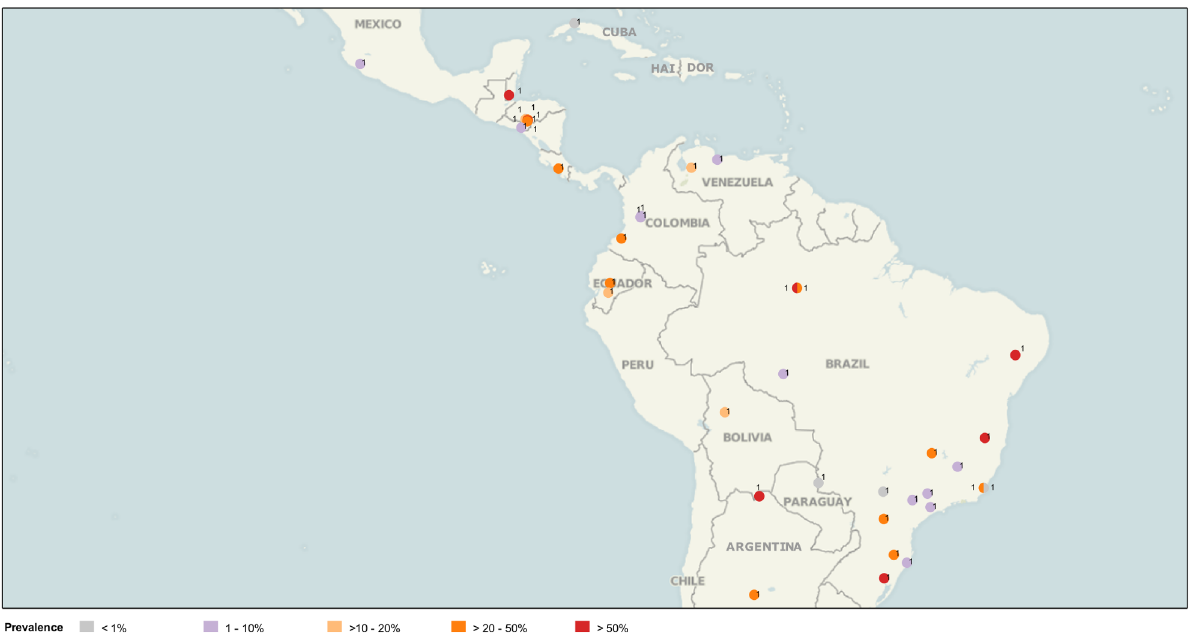
tableausoftware.com/mapdata).